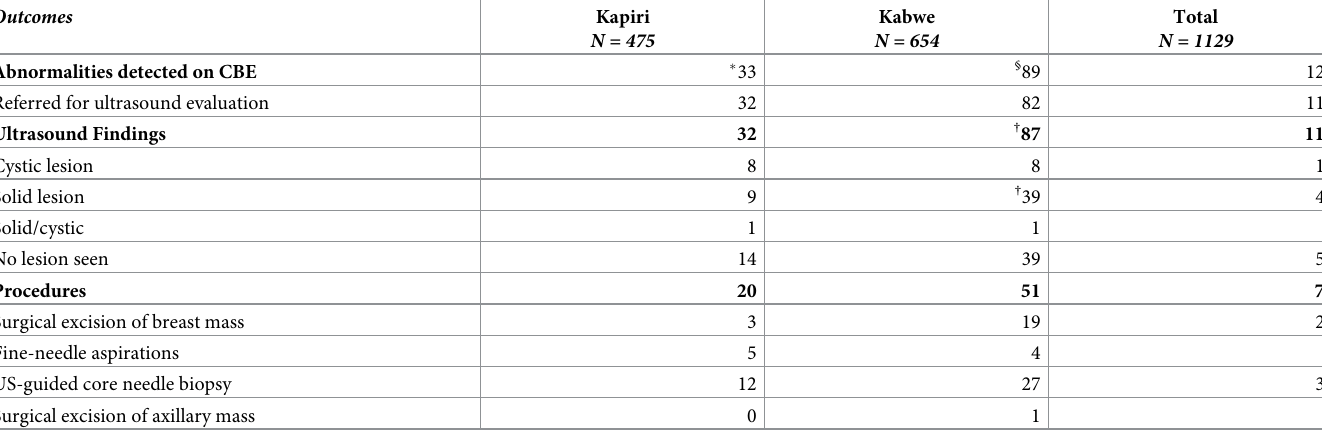
Table 2. Diagnostic outcomes.